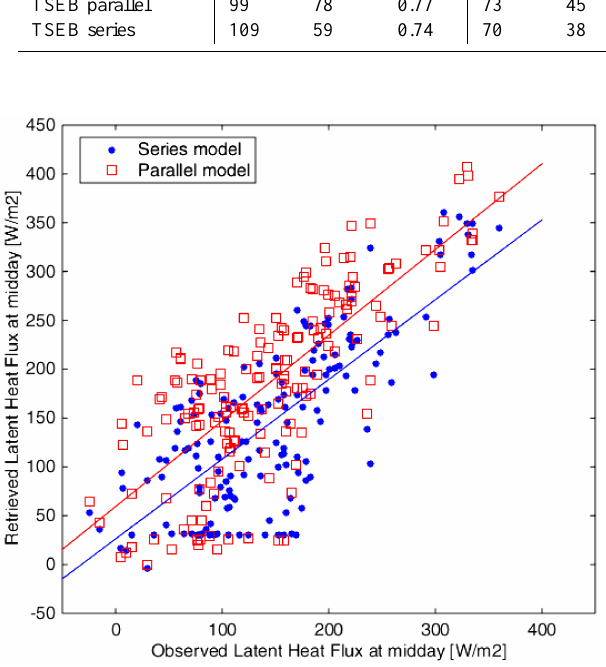
Figure 6. Scatterplot of retrieved vs. observed latent heat flux at midday at the rainfed wheat site.